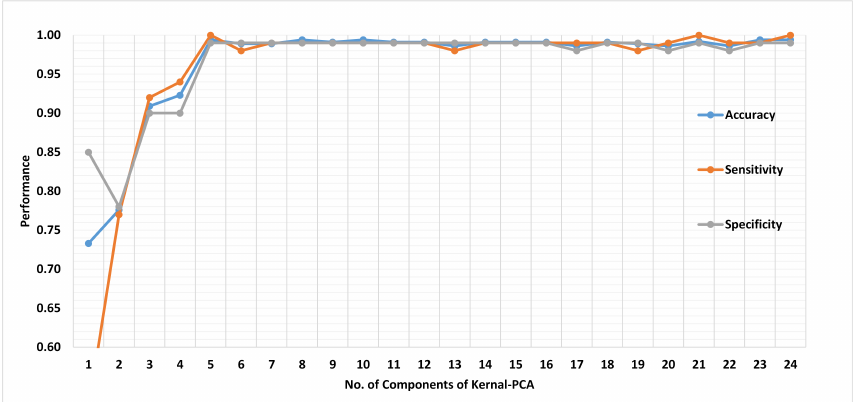
Figure 20. Performance of method II in terms of accuracy, sensitivity, and specificity for 1 to 24 trans- formed